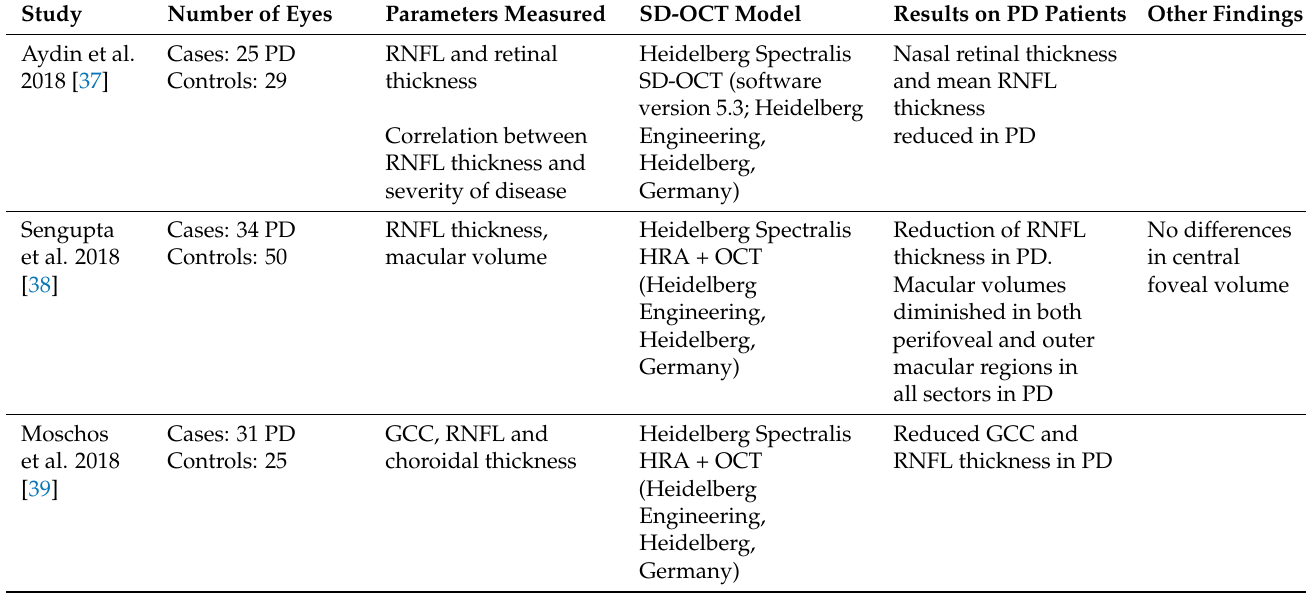
Table 1. Clinical characteristics included spectral-domain optical coherence tomography studies.